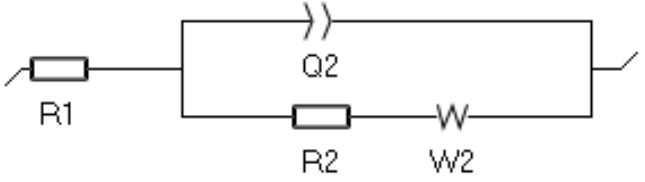
Figure 18. Bode plot for as-cast NAB alloy and FS-processed composite in 3.5 wt.% NaCl solutions. Figure 19. Equivalent circuit model used to fit the impedance data. Figure 19. Equivalent circuit model used to fit the impedance data. Figure 19. Equivalent circuit model used to fit the impedance data. Table 4. Fitted electrochemical parameters.